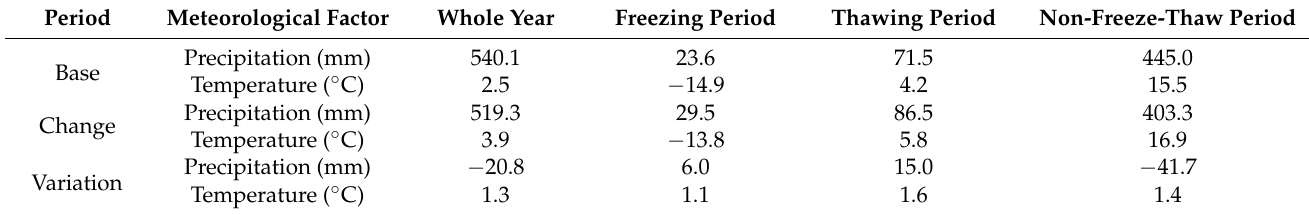
Table 7. Changes in meteorological factors.